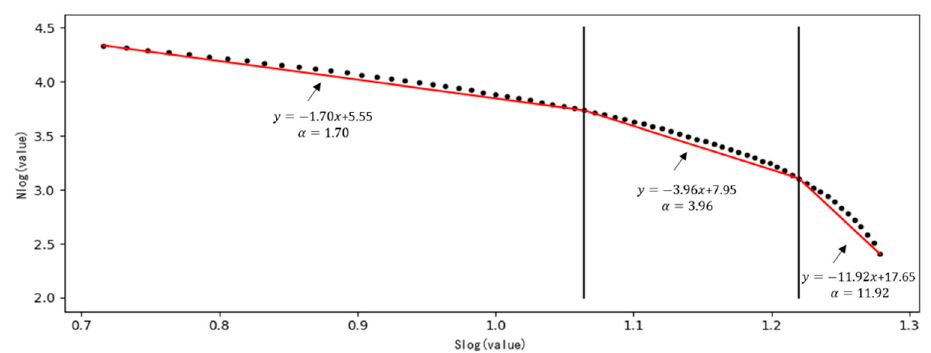
Figure 6. Fractal fitting of impact crater size (The black dots present the 𝑙𝑜𝑔(𝑆) − 𝑙𝑜𝑔(𝐴) double logarithmic plot results).